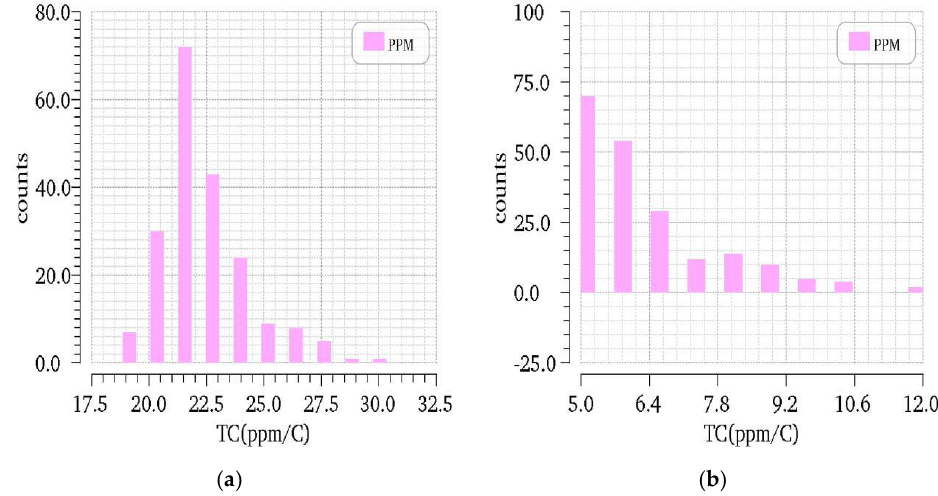
Figure 8. In reference 2 ( a ) V-T curve after first-order temperature compensation; ( b ) V-T curve after high-order tempera- ture compensation.